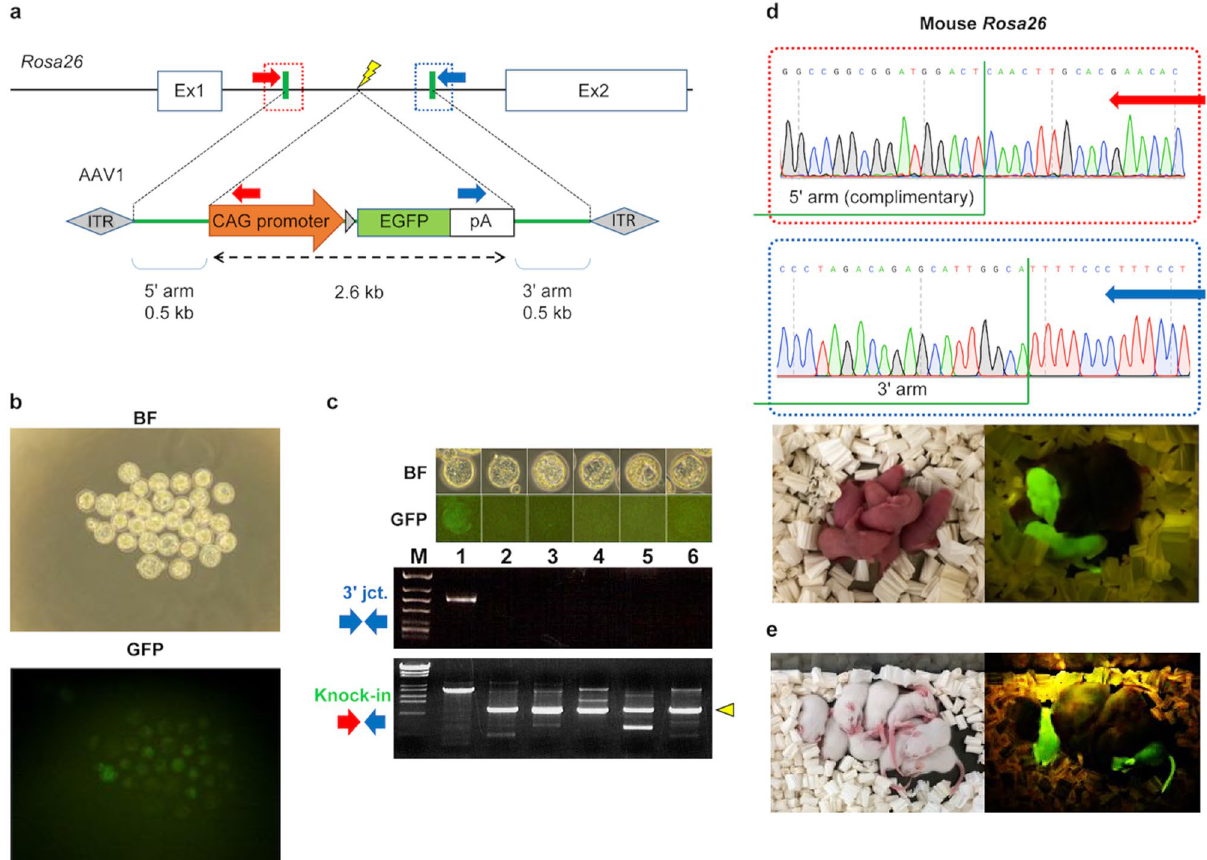
Figure 1. Generation of knock-in mice by simultaneous electroporation of Cas9 RNP and AAV vectors ex vivo. ( a ) Targeting strategy for CAG-EGFP knock-in into the mouse Rosa26 locus. Red and blue arrows indicate PCR primers for 5 ′ and 3 ′ junction genotyping. Green vertical bars represent 5 ′ and 3 ′ junctions. A small gray triangle shows a loxP sequence. ITR: inverted terminal repeat; pA: rabbit beta-globin polyadenylation signal. ( b ) Representative fluorescent microscopy of embryos electroporated with CRISPR RNP and AAV1-CAG-EGFP vector. BF: bright-field microscopy. (c ) PCR products amplified from genomic DNAs of individual blastocysts. Insertion of CAG-EGFP cassette in the Rosa26 locus was detected from an embryo (No.1) expressing EGFP fluorescence. 3 ′ expected band size: 0.6 kb; knock-in expected band size: 3.6 kb; wild-type expected band size (yellow triangle): 1.1 kb. Sanger sequencing confirmed that correctly edited 3 ′ junction of the Rosa26 locus, although the 5 ′ junction was incorrect in this embryo (data not shown). Faint PCR products were detected in several samples; however, they are thought to be due to nonspecific amplification because they are not detected as signals by Sanger sequencing. M, λ- Sty I (lower) or ϕX174- Hinc II (upper) digested DNA marker (Supplementary Fig. S4). ( d ) Correct HR in embryos was confirmed by Sanger sequencing. ICR pups expressing EGFP fluorescence were obtained after ex vivo electroporation of CRISPR RNP and AAV1 donors. ( e ) The germline transmission of the edited Rosa26 locus was confirmed in the next